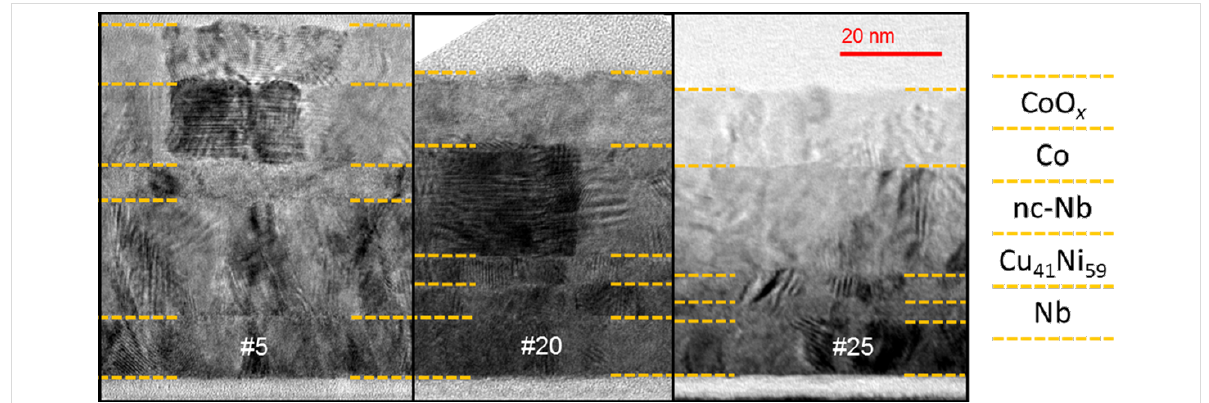
Figure 2: Cross-sectional TEM images of samples SF 1 NF 2 -AF1 #5, #20, and #25 from left to right. The dashed yellow lines indicate the interfaces be- tween the layers. The obtained layer thicknesses are given in Table 1.